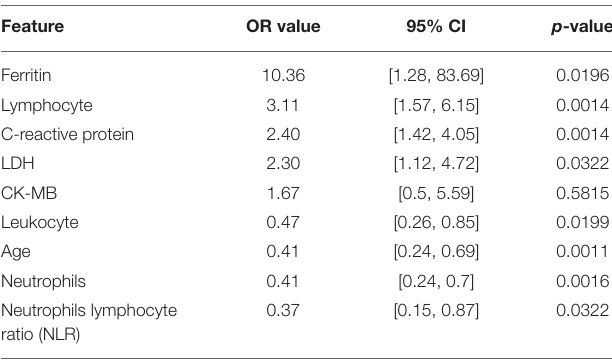
TABLE 2 | Odds ratio for